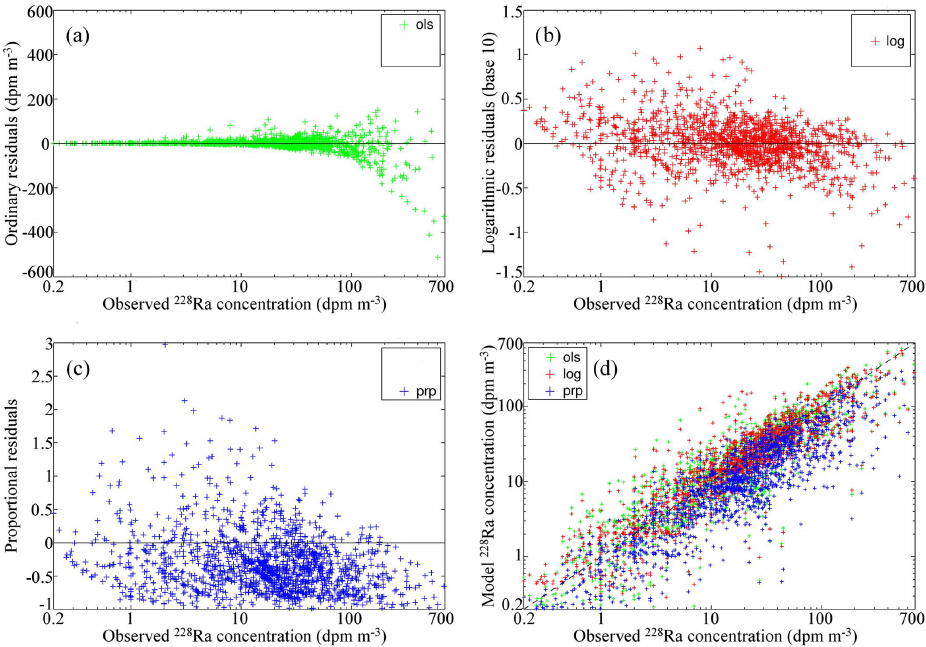
Figure 6. (a) Residuals, (b) logarithmic residuals, (c) proportional residuals, and (d) model 228 Ra concentration as a function of observed 228 Ra concentration. Lines of zero residuals are drawn in